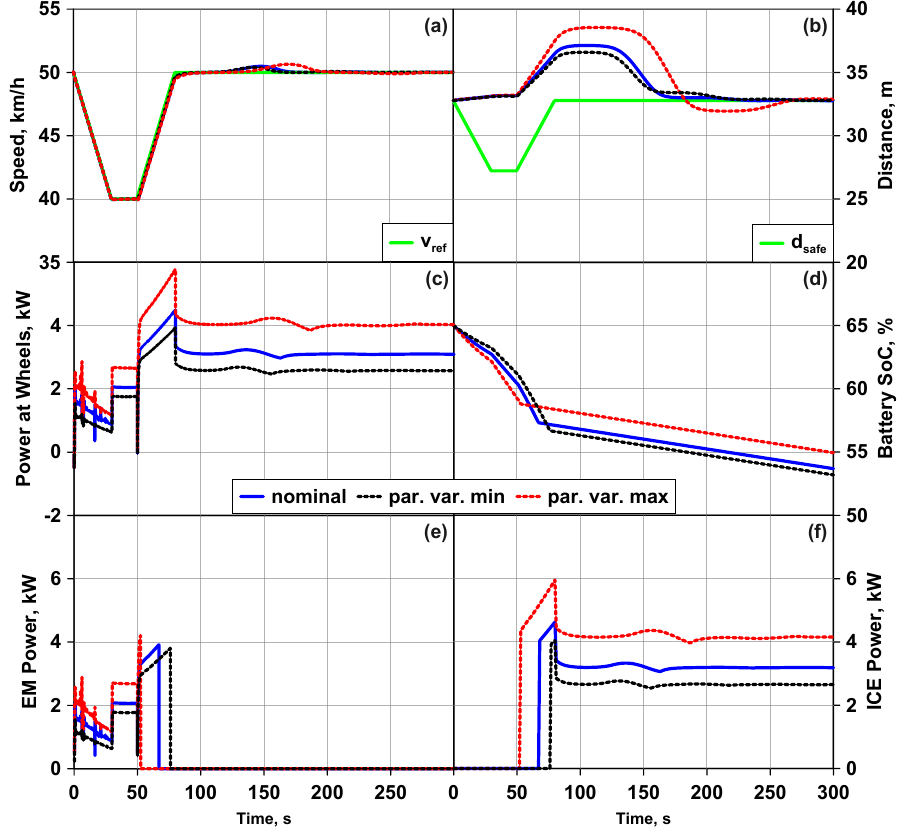
Figure 13. Robustness test (blue: nominal values, dashed red: maximum values, dashed black: minimum values)—( a ) speed (km/h); ( b ) relative distance (m); ( c ) wheel power (kW); ( d ) battery SoC (%); ( e ) EM power (kW); ( f ) ICE power